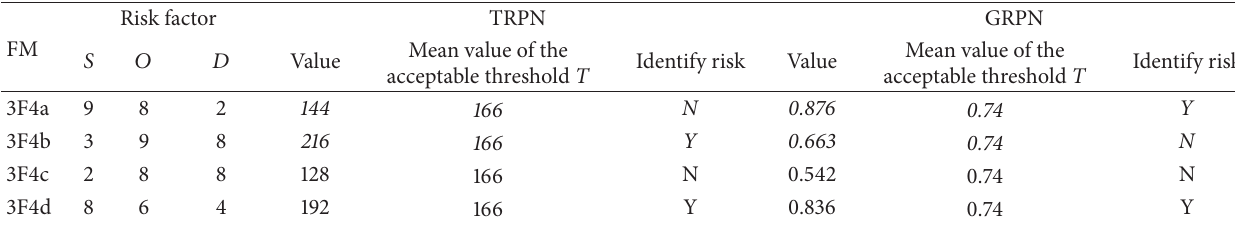
Table 10: Comparison of the TRPN and GRPN test procedures—scenario 1.